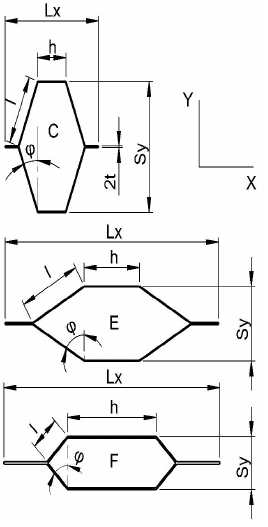
Figure 1. The shape of cells used for research.